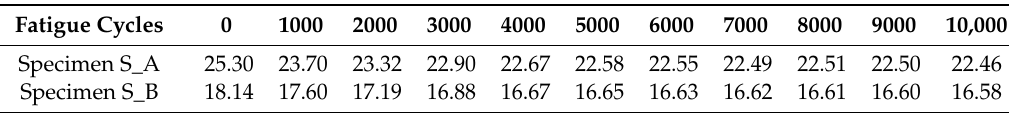
Table 1. Longitudinal stiffness data for GF/EP specimens under fatigue cycles (Unit: GPa).